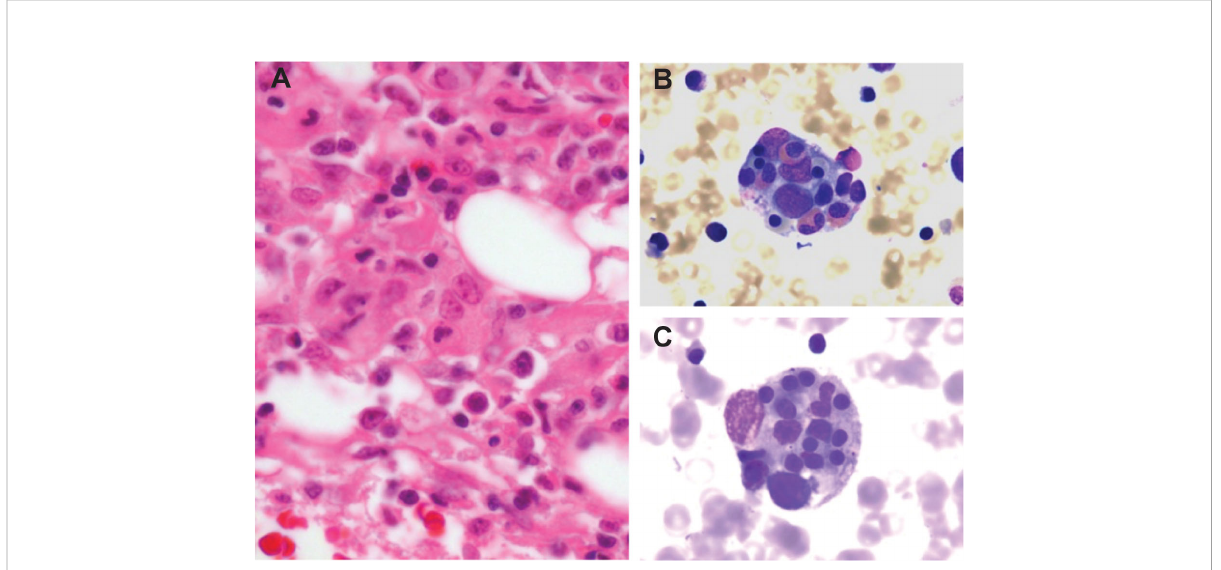
FIGURE 1 Histopathology of HLH (A) Histopathology of a bone marrow section in HLH demonstrates marrow in fi ltration by macrophages (hematoxylin and eosin stained, 400x magni fi cation). (B, C) Bone marrow aspirate stain demonstrates macrophages engul fi ng hematopoietic cells, including eosinophils and erythroid precursors (Wright-Giemsa stained, 1000x magni fi